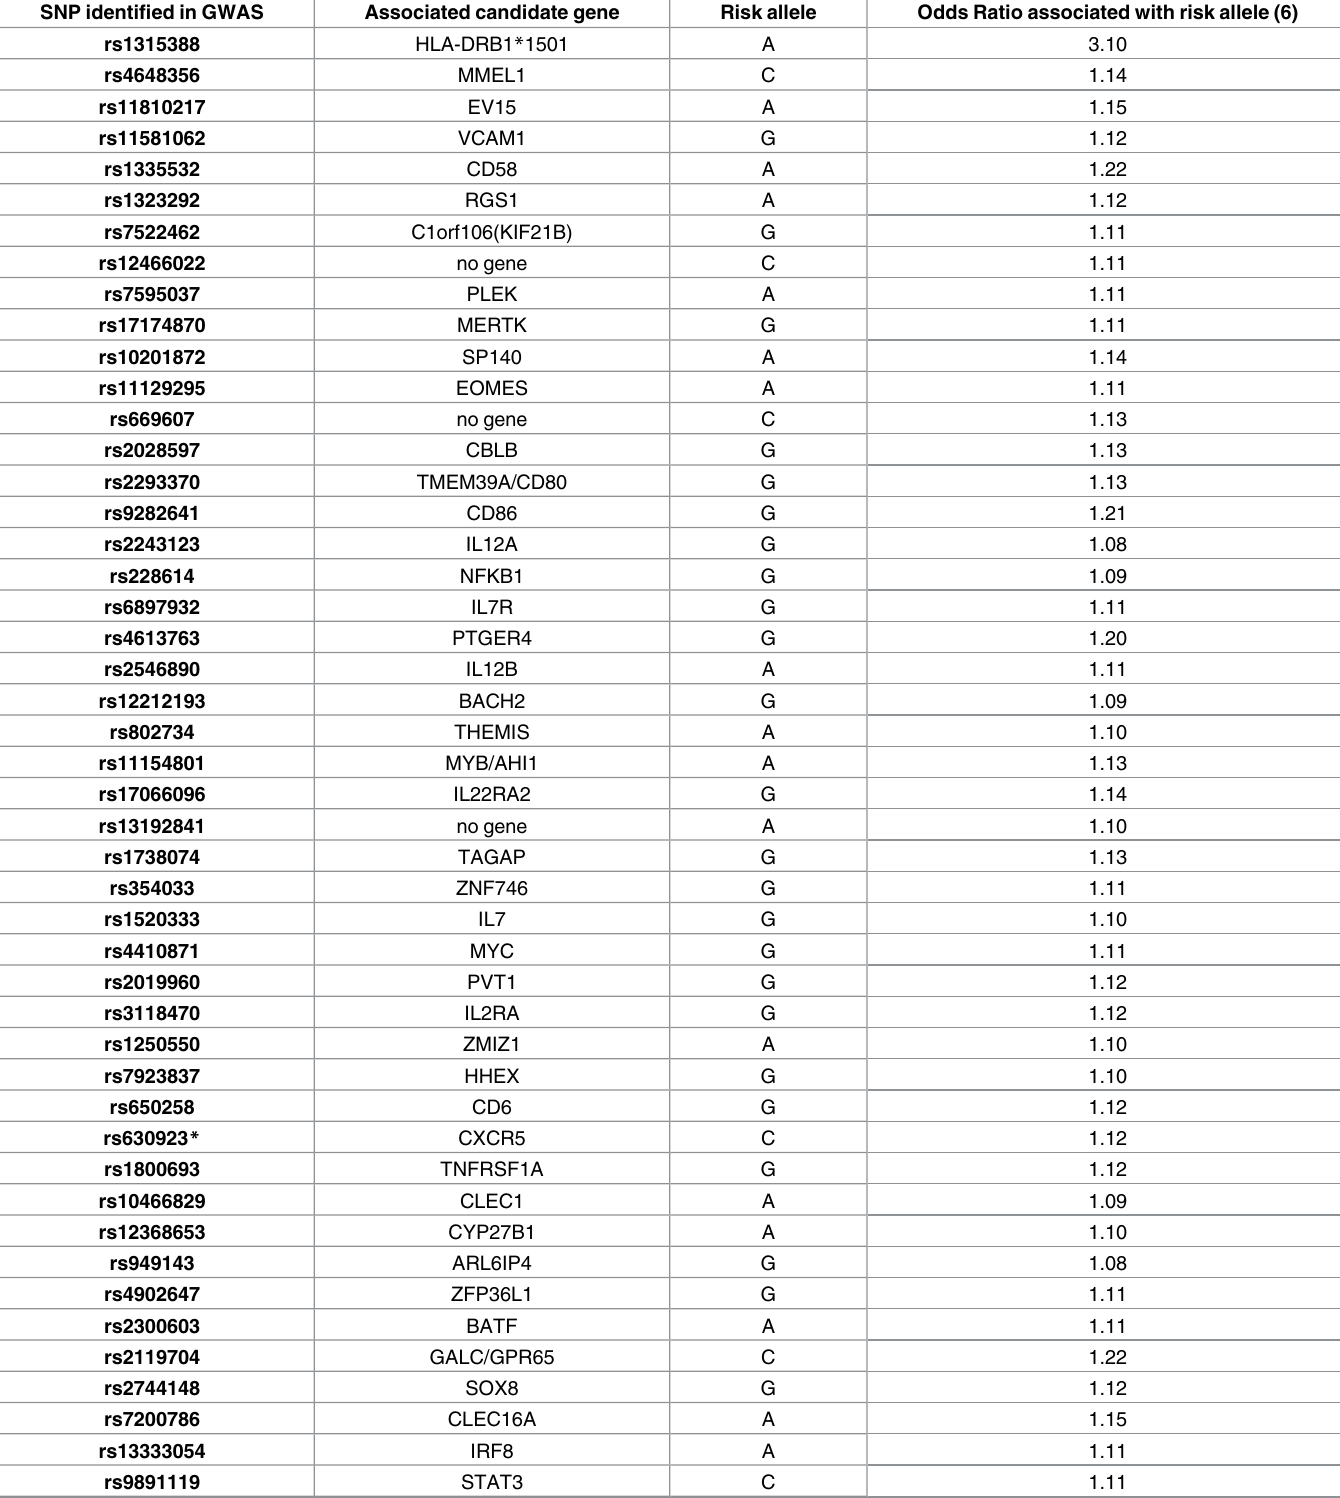
Table 3. SNPs associated with MS available on the Illumina Immunochip. SNP identified in